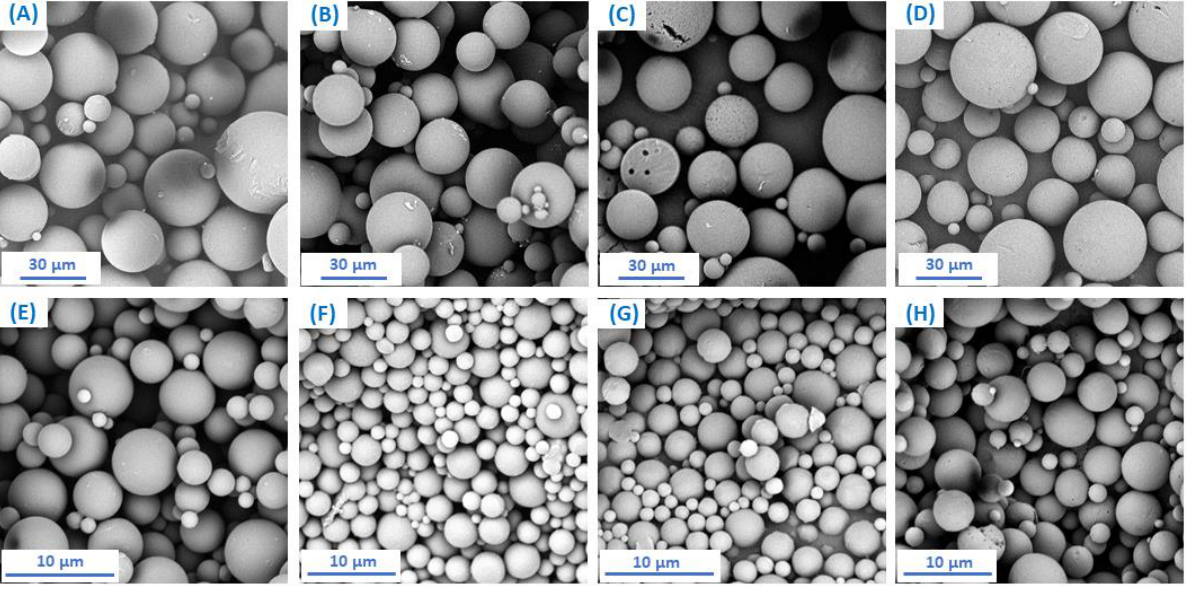
Table 5. Size and size distribution of blank microspheres calculated from optical microscope. Polyanhydride